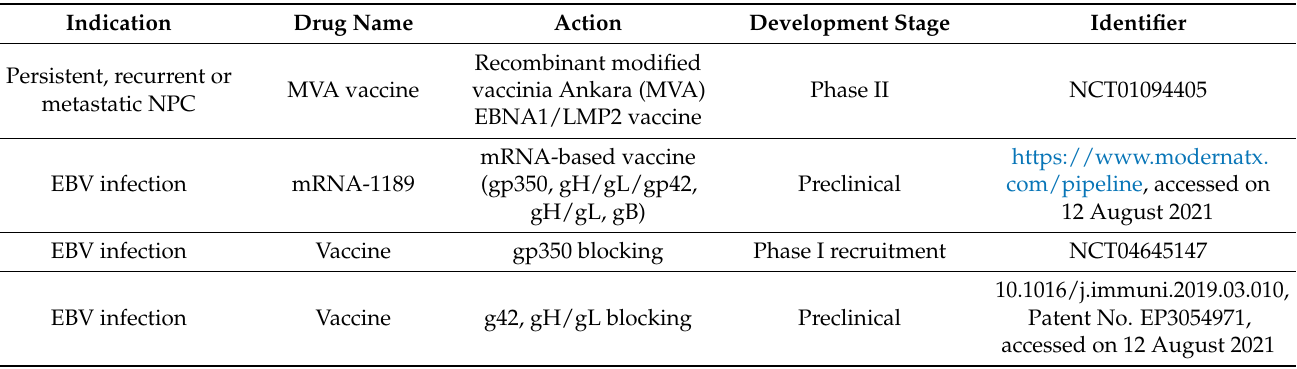
Table 7. EBV-specific vaccine